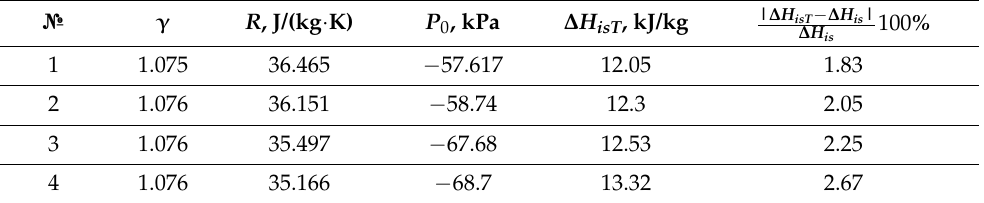
Table 8. Constants of the Tammann equation of state and the resultant isentropic enthalpy drop.